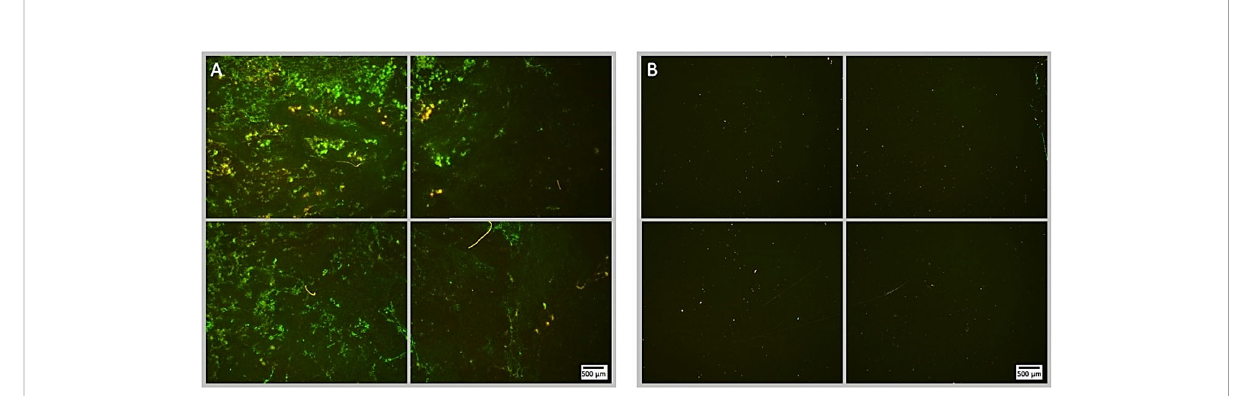
FIGURE 4 Fluorescence microscopy images of P. aeruginosa bio fi lm treated with NOMB without antibiotic, stained with Syto9 (green) and PI (red). Panel (A) images depict the pre-treatment morphology of the bio fi lm over a 1 cm 2 area. Panel (B) images show the changes in attached biomass after ultrasound stimulation of NOMB without antibiotic; 45 Vpp was applied to the transducer to reach an acoustic pressure of 0.5 MPa at the target site for 40 s, with a driving frequency of 0.9 MHz, duty cycle of 20% and a 500 Hz PRF. Though a considerable proportion of the bio fi lm has been removed, there is clear evidence of both residual MBs, and bio fi lm still associated with the